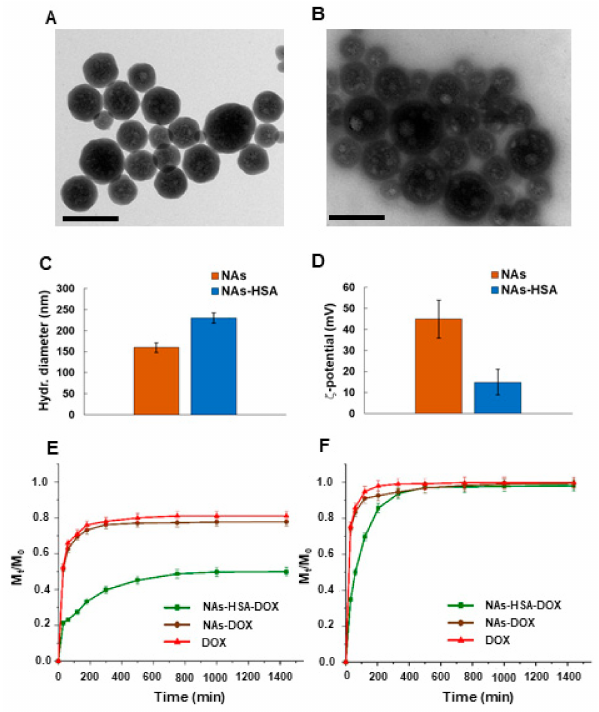
Figure 1. Characterization of Nanoparticles; TEM analysis of (A) NAs and (B) NAs-HSA (scale bar 200 nm); DLS measurements for the determination of (C) size and (D) zeta potential of NAs and NAs-HSA. pH responsive DOX release profile (M t /M 0 ) from NAs-HSA ( (cid:4) ), NAs ( • ) and DOX solution ( (cid:78) ) at (E) pH 7.4 and (F) pH 5.0 recorded by UV-Vis spectroscopy. The effective